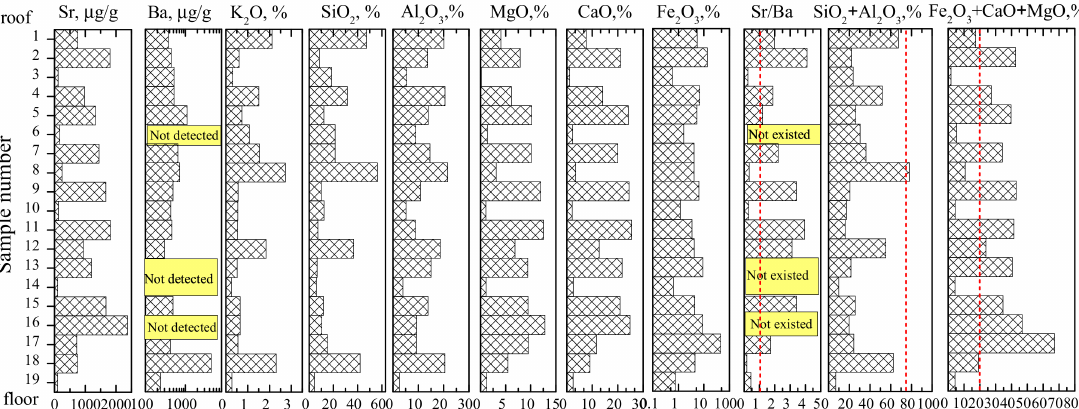
Figure 12. Variations of partial chemical compositions of the coal